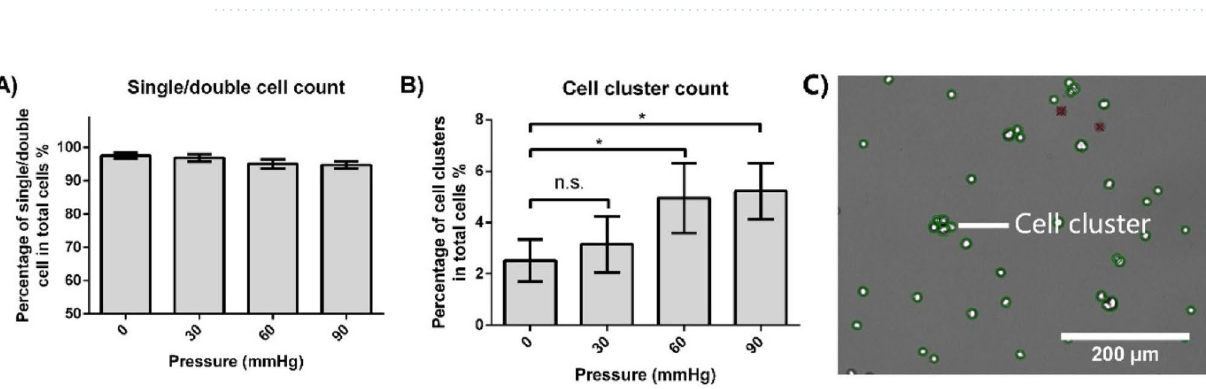
Table 1. Integral of viable cells and normalized IgG 1 concentration at Day 5 (Value in the table is shown as mean ± SEM). Comparing 30, 60 and 90 mmHg pressure conditions with 0 mmHg, the result of their two- tailed T-test was included. n.s. is p > 0.05. * is p < 0.05.